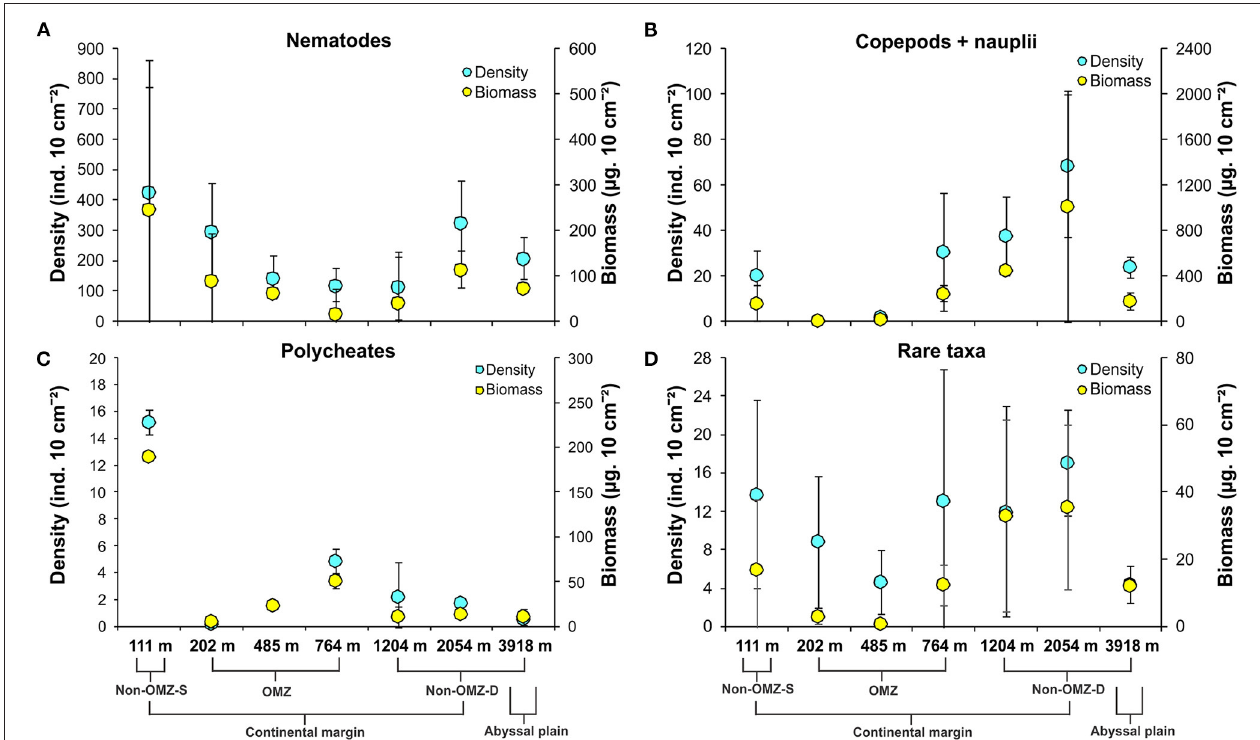
FIGURE 4 | Distribution of density (mean ± SD) and biomass (mean ± SD) of major meiofaunal taxa along the depth gradient of the WICM and abyssal plain. (A) Nematoda; (B) Copepoda + Nauplii; (C) Polychaeta; (D) . Rare taxa include nemerteans, ostracods, bivalves, kinorhynchs, gastropods, arachnids, minor phyla, tardigrades, tanaids, turbellarians, insects, oligochaetes, gastrotrichs, sipunculids, cumaceans, isopods, cnidarians, and